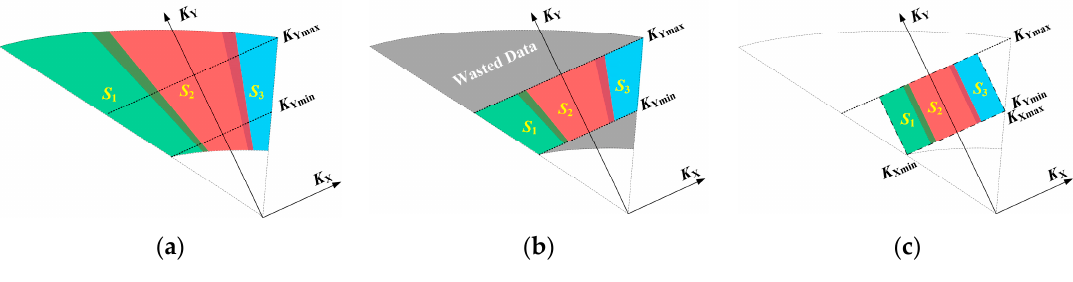
Figure 5. Wavenumber data distributed in: ( a ) polar format; ( b ) keystone format; and ( c ) rectangular format.